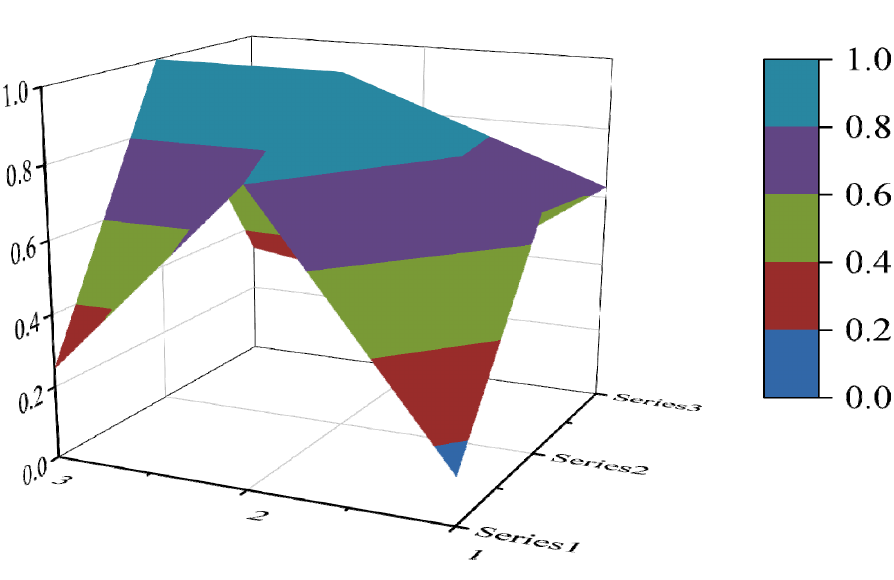
Figure 2. The PMC surface of P1.